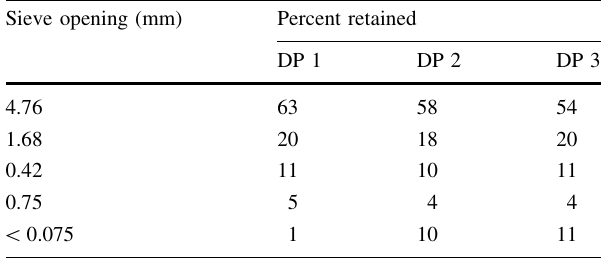
Table 5 Particle size distribution of materials used in Proctor tests